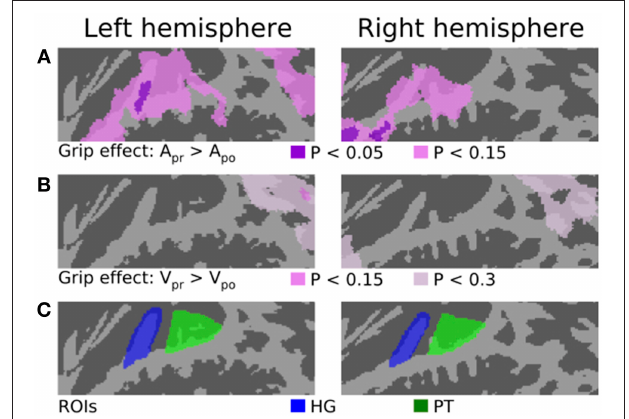
FIGURE 2 | The effect of grip and ROIs. (A) The areas where activations were stronger during A pr than A po blocks. The results are plotted with two thresholds (corrected P < 0.05 and corrected P < 0.15 ). The opposite contrast (A po > A pr ) showed no significant effects. (B) The areas where activations were stronger during V pr than V po blocks (corrected P < 0.15 and corrected P < 0.3 ). ( C) ROIs in HG and